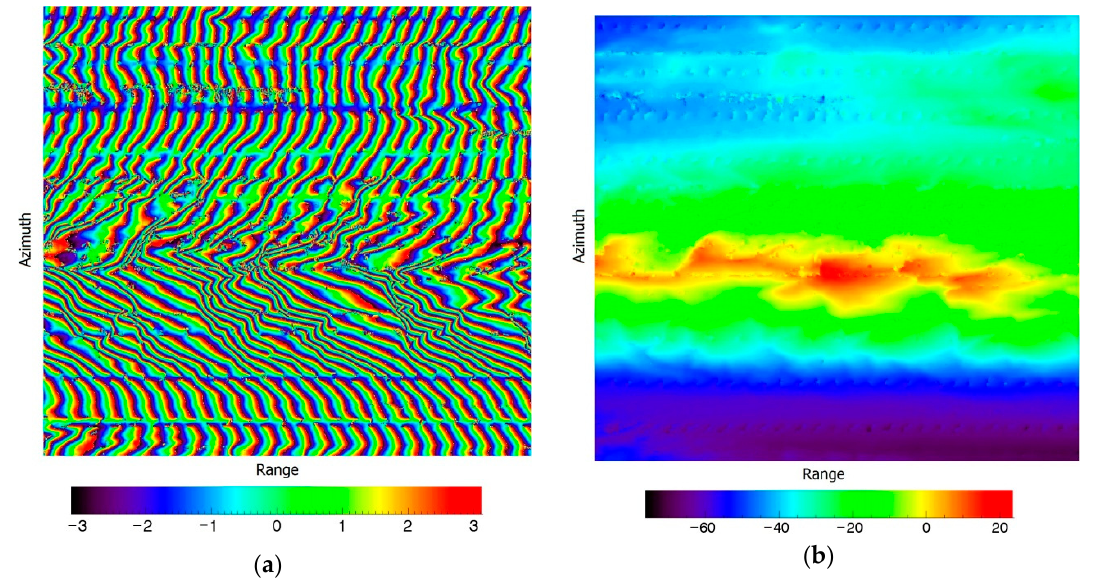
Figure 7. The second-order compensation results. ( a ) The second-order compensated denoised interferometric phase (rad); ( b ) the second-order compensated unwrapped phase after flat Earth removal along the range direction (rad).